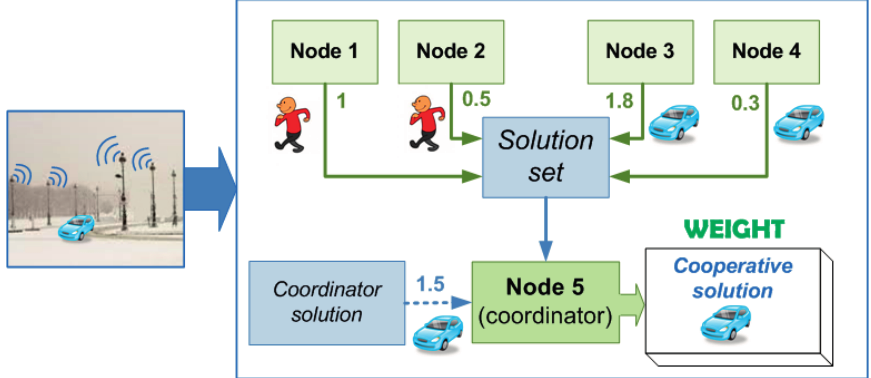
Figure 7. General weight-based